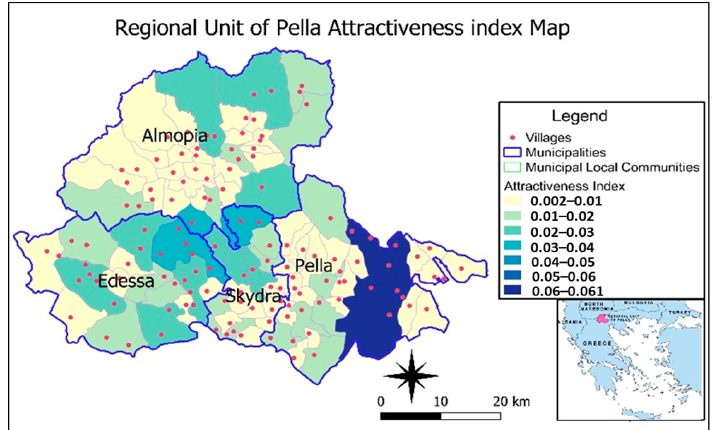
Figure A1. Graded Attractiveness Map (RAI).